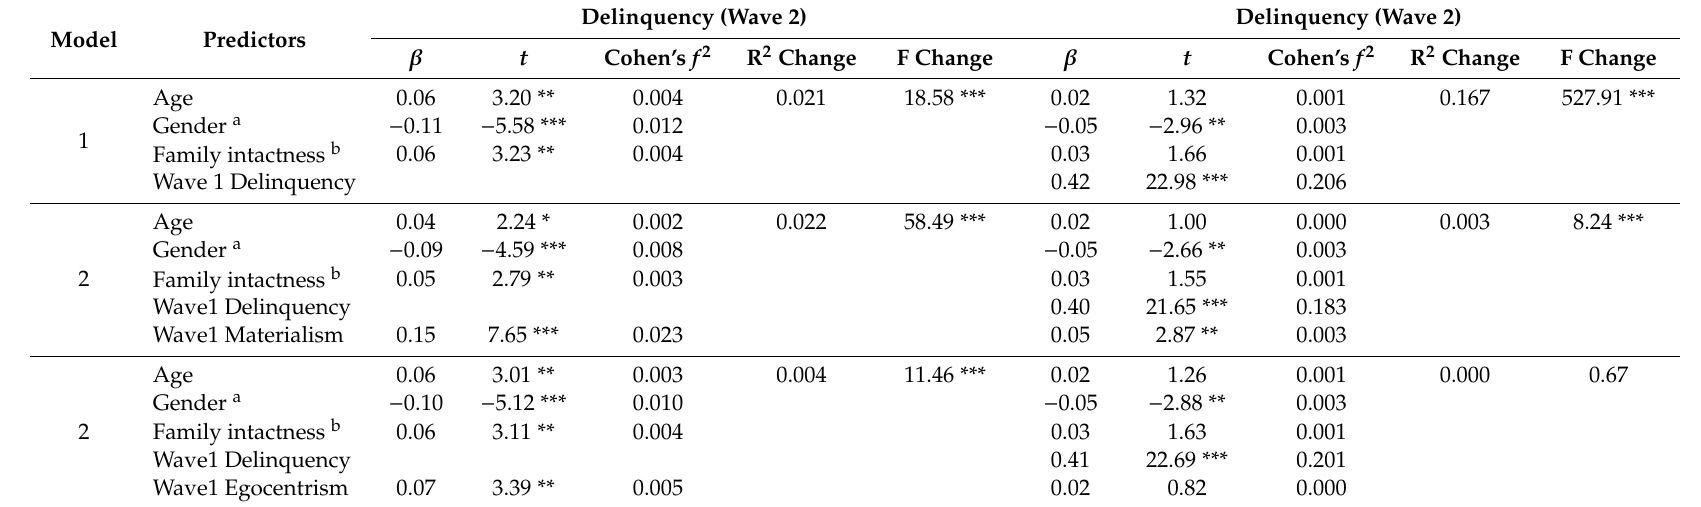
Table 4. Longitudinal regression analyses for delinquency.